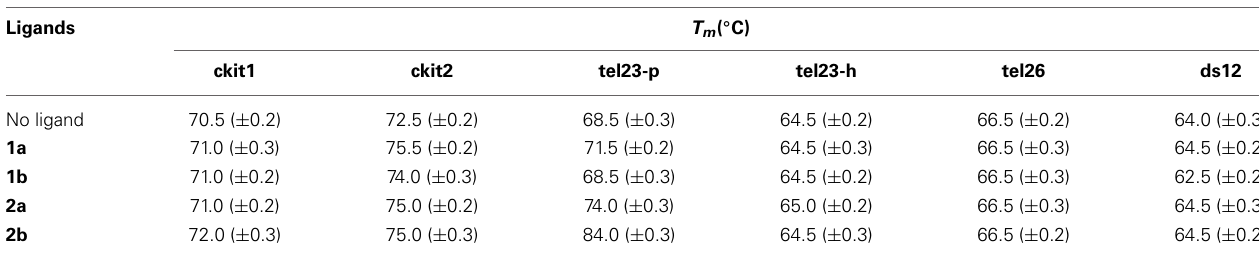
Table 1 | Melting